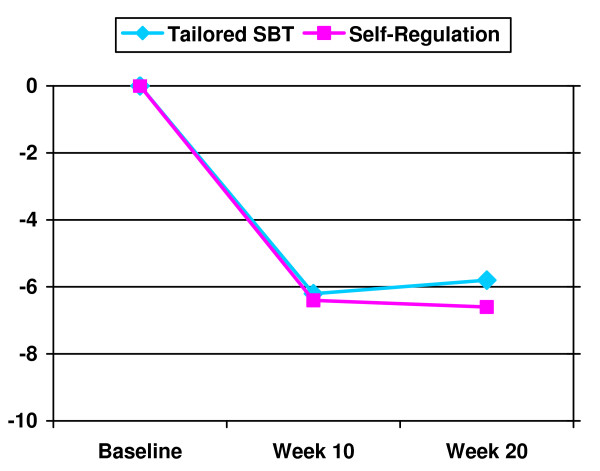
Weight Change in Kilograms over Time.